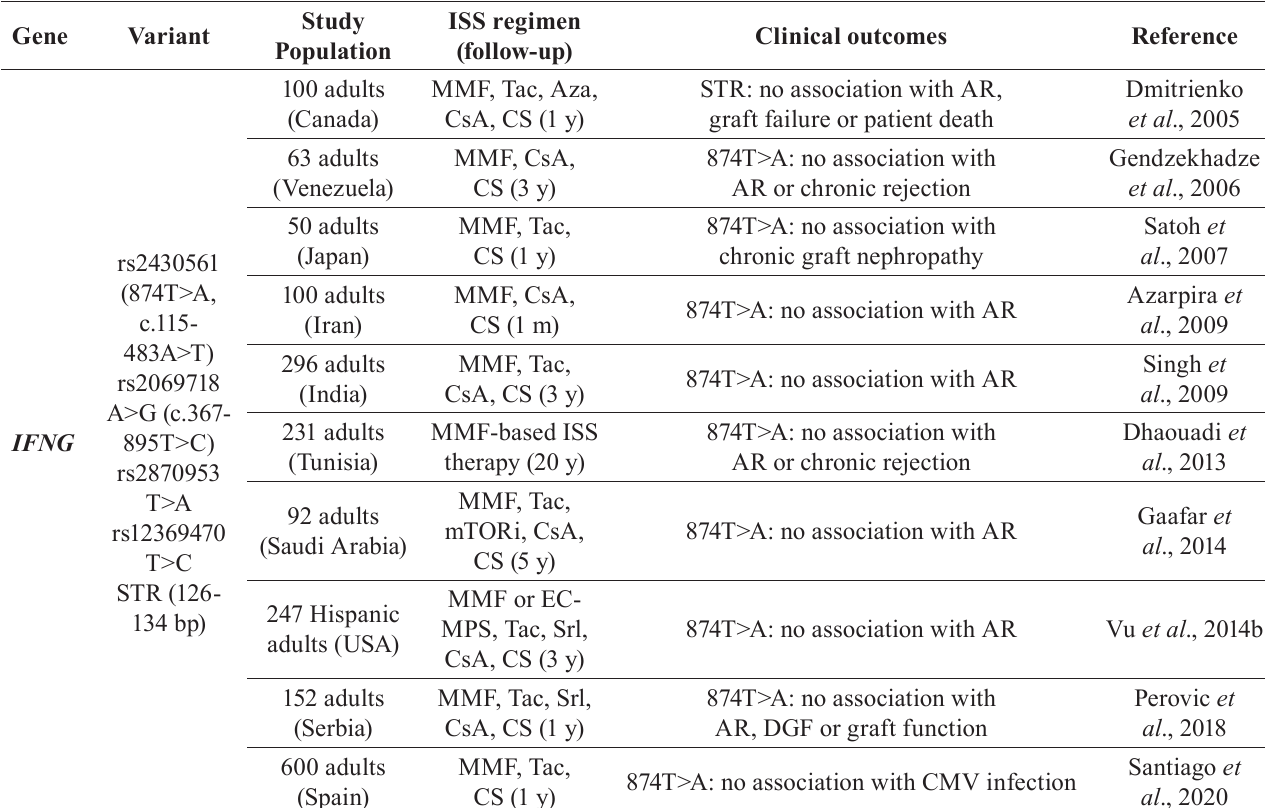
TABLE IV - Genes related to pro-inflammatory cytokines in kidney recipients on MPA therapy without significant associations